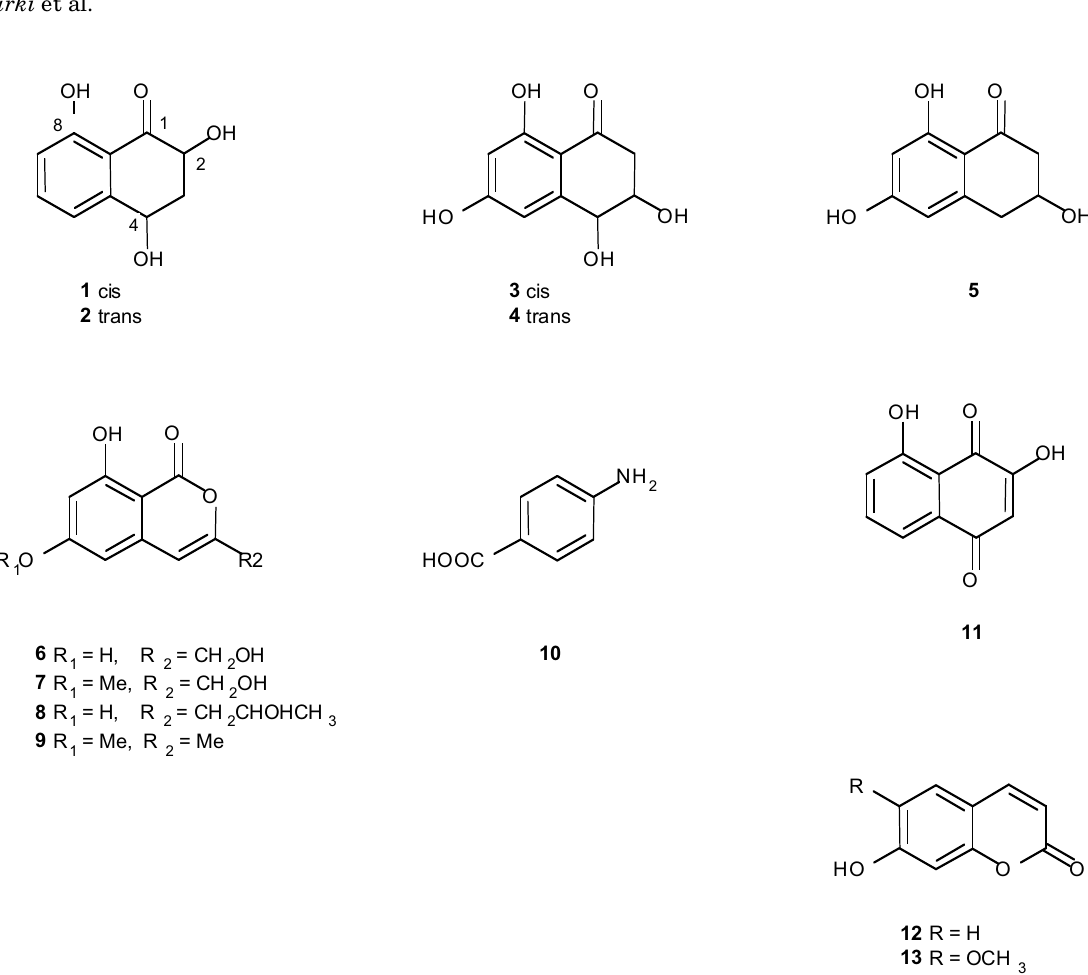
Fig. 1. Structure of the compounds isolated from the culture medium of Ceratocystis fimbriata f. sp. platani and (or) from wood infected by the